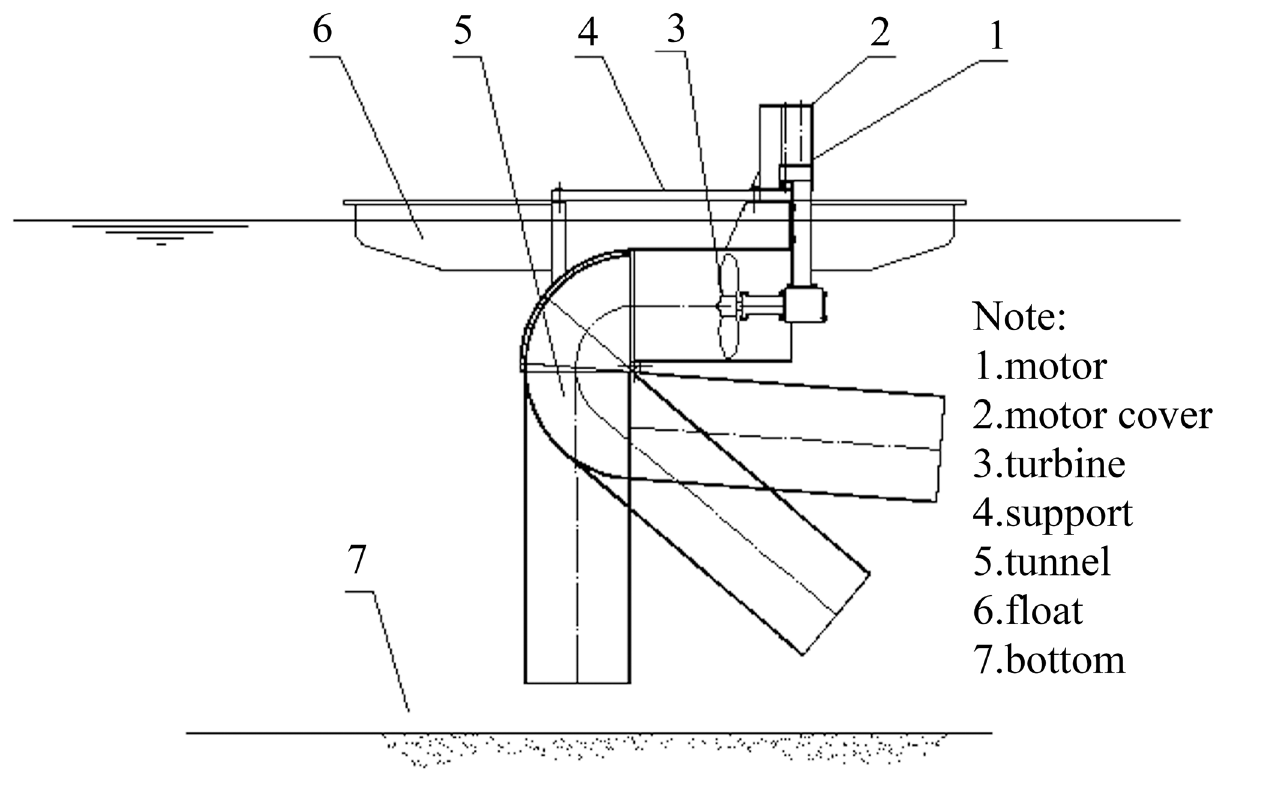
Fig 2. Structure of the sediment